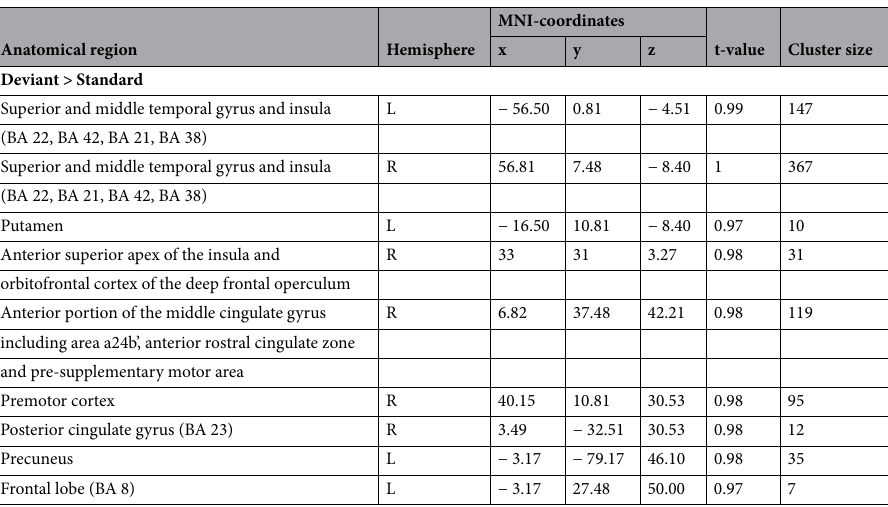
Table 1. Significant clusters activated more strongly during deviance detection. Low-probability ending triplets contrasted to high-probability ending triplets, i.e., Deviant > Standard. The table shows the results that survived the correction for multiple comparisons (p <